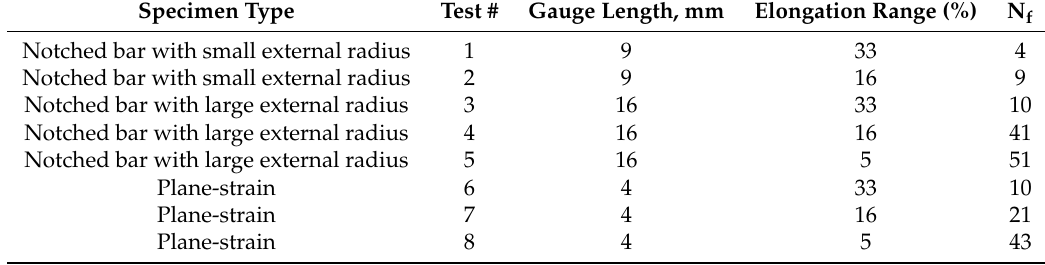
Table 5. Inconel 718 chemical composition as received.